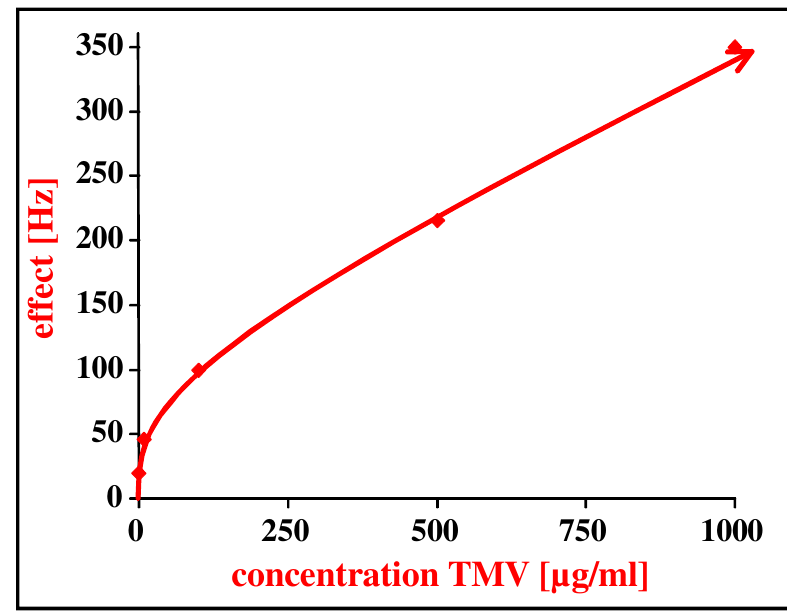
Figure 10: Sensor characteristic for a TMV-imprinted material It shows several advantageous features: the dynamic range is comparably high (three orders